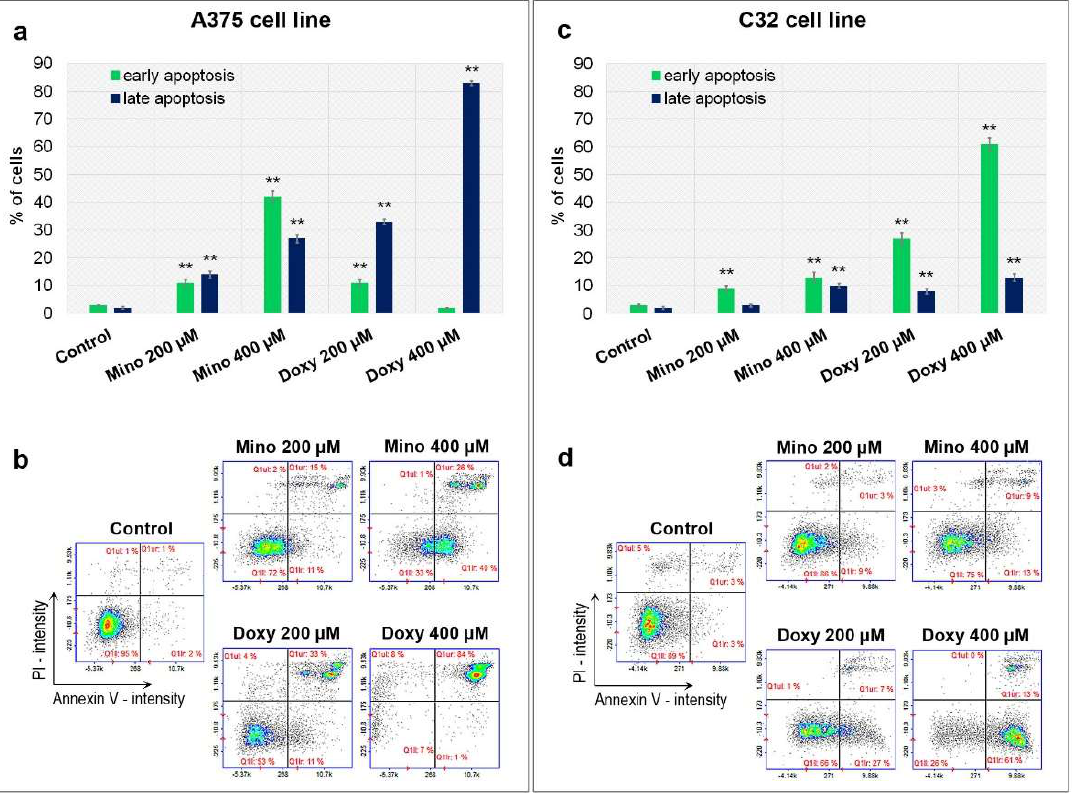
Figure 5. Analysis of apoptosis after the treatment of melanoma cells with minocycline and doxycycline. Bar graphs present the results for A375 ( a ) and C32 ( c ) cell lines. Representative scatter plots ( b , d ) display tested populations of stained cells divided by a gate into the subpopulations of non-apoptotic, early, and late apoptotic cells. ** p < 0.005 vs. control.